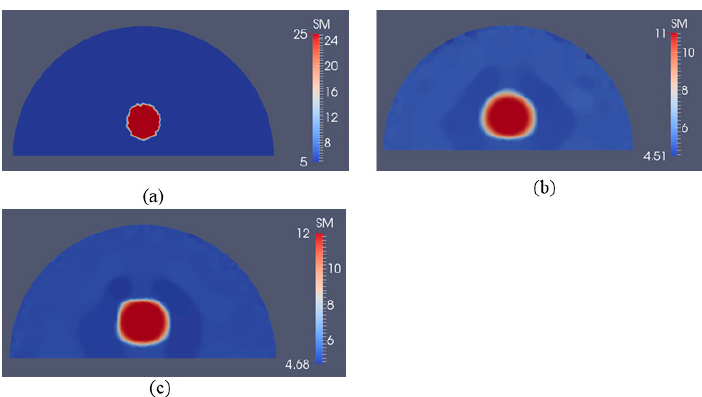
Figure 8. Shear modulus reconstructions with 0.1% noise. ( a ) target shear modulus distribution with varied inclusion depth in comparison to previous target problem domain in Figure 4a,b; ( b , c ) reconstructed shear modulus distribution using 5 and 10 boundary displacement data sets, respectively (unit in the scale bar: kPa). Note: “SM” stands for shear modulus.